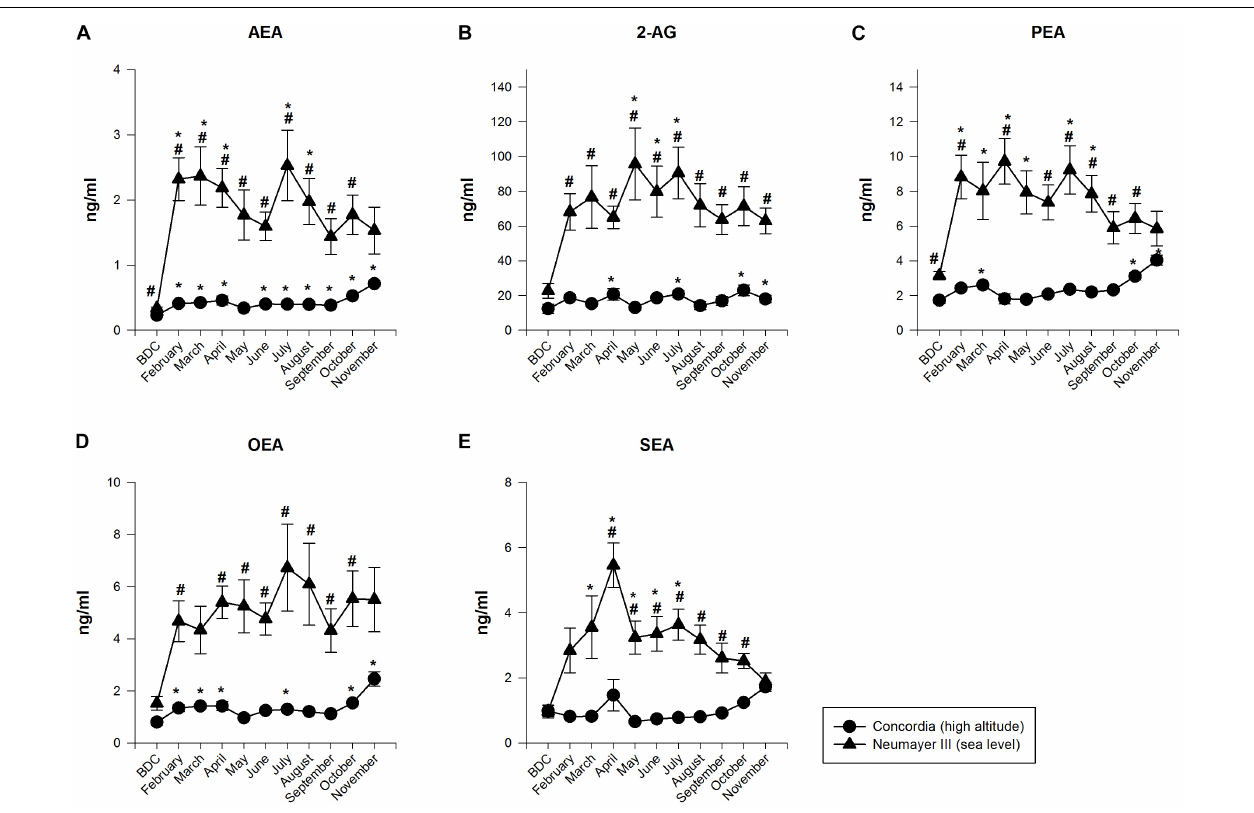
FIGURE 1 | Endocannabinoid (EC) and N -acylethanolamide plasma concentrations at Neumayer III (sea level) ( n = 7–15) and Concordia (high altitude) ( n = 15–16); data are means ± SEM; units are ng/ml; BDC, baseline data collection; AEA, anandamide (A) ; 2-AG, 2-arachidonoylglycerol (B) ; PEA, palmitoylethanolamide (C) ; OEA, oleoylethanolamide (D) ; SEA, stearoylethanolamide (E) ; ∗ significant difference to BDC; # significant difference between Neumayer III (sea level) and Concordia (high altitude)